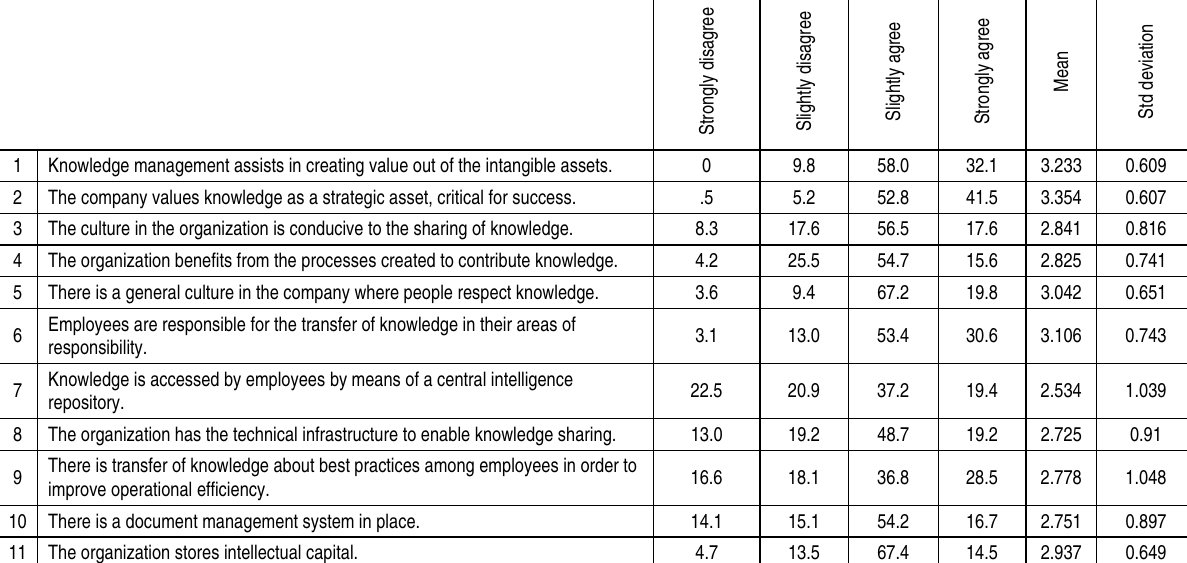
Table 1. Results of the questionnaire on knowledge